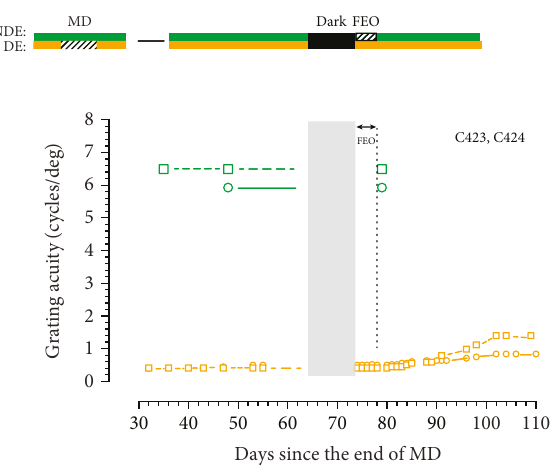
Figure 5: The grating acuity of the deprived eye acuity (orange symbols) and the binocular acuity (green symbols) of two monocularly deprived littermates C423 (square symbols) and C424 (circle symbols) surrounding 10 days of total darkness followed immediately by a 4-day period of fellow eye occlusion (FEO). Whereas the period of FEO e ff ectively blocked any improvement of the acuity of the deprived eye following the period of darkness, it did not result in any reduction of the acuity ofthe nondeprived eye.